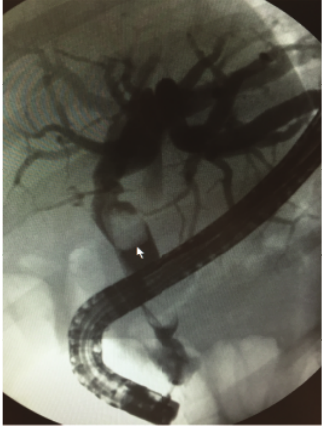
Figure 3: Endoscopic retrograde